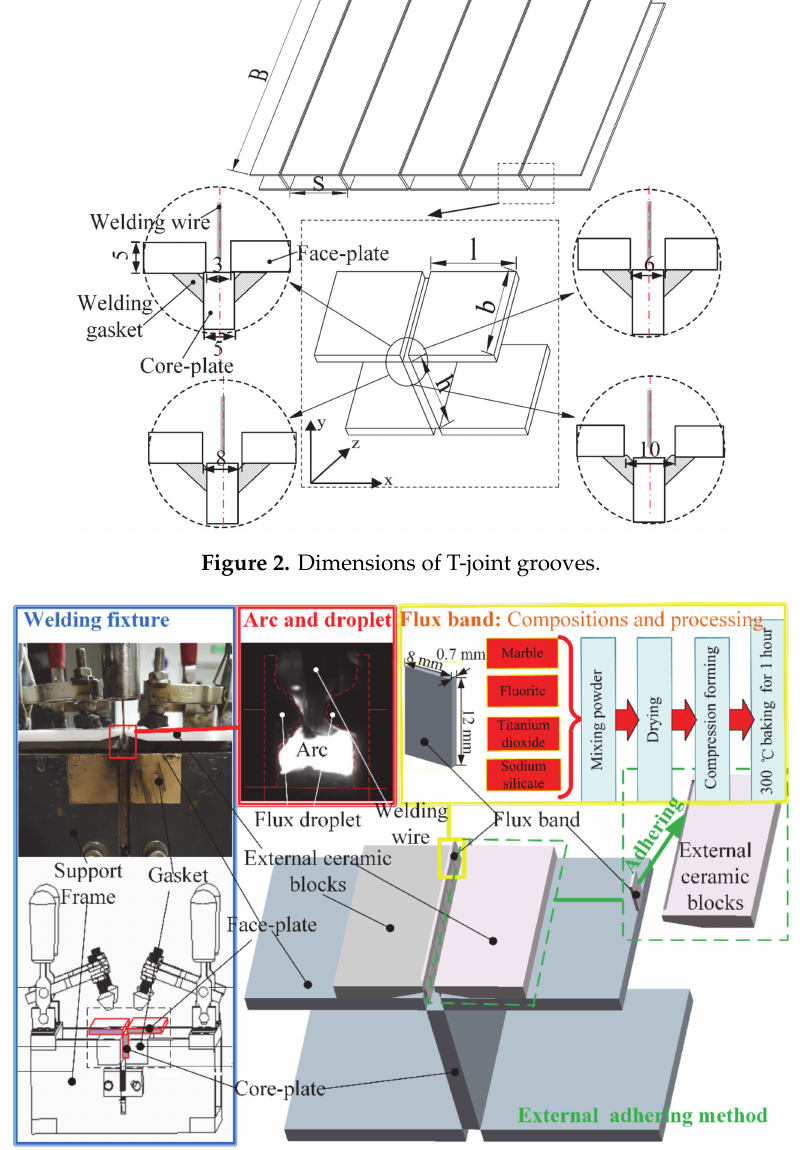
Figure 3. Flux bands and outside adhering method of FBCA welding. Table 2. The chemical compositions of flux band (wt.